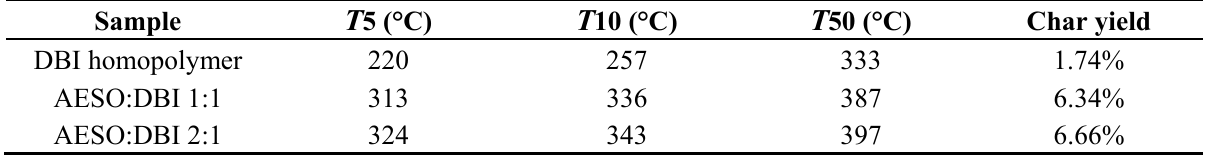
Table 1. Thermogravimetric data for DBI and EC homopolymers, AESO-DBI, and AESO-EC resins. T 5, T 10, and T 50 temperatures correspond to mass loss of 5%, 10%, and 50% respectively. Char yield is based on residue at 700